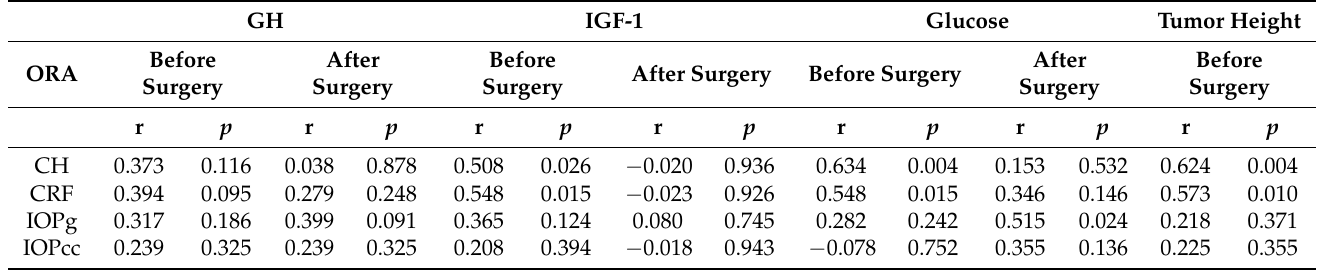
Table 4. Correlation analyses between GH, IGF-1, glucose, tumor height and ORA parameters in the study group before and after